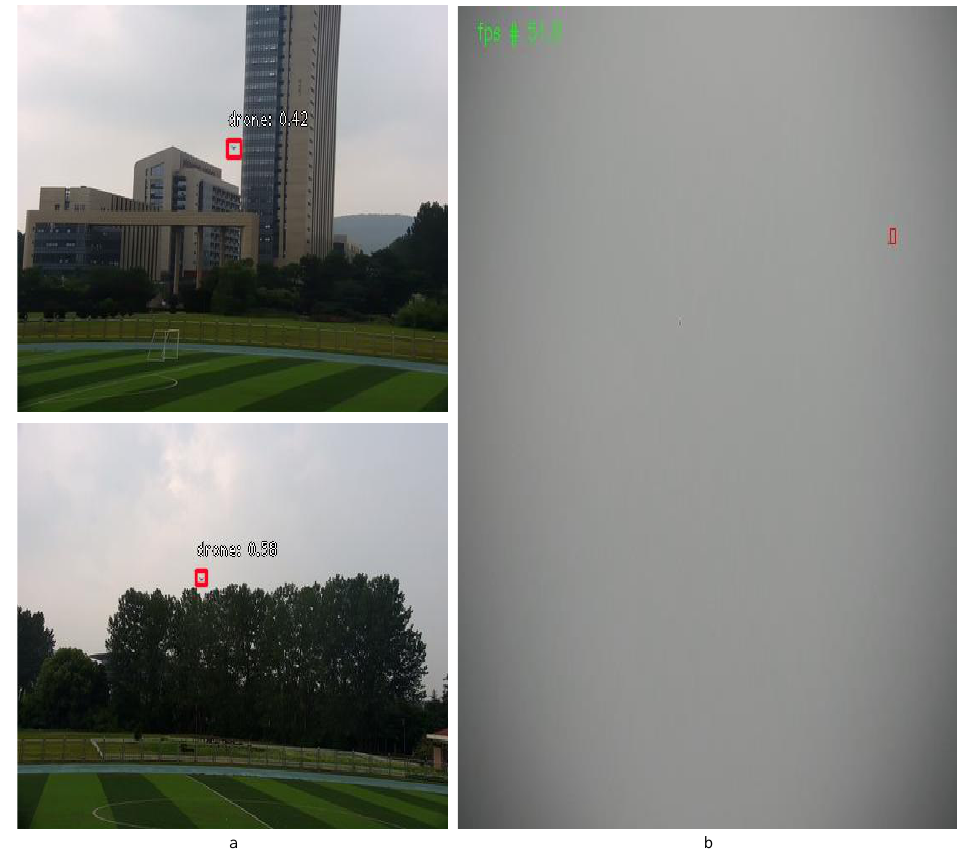
Figure 12. Results of the proposed system under far distance: ( a ) Illustration of confidence score and ( b ) illustration of FPS.